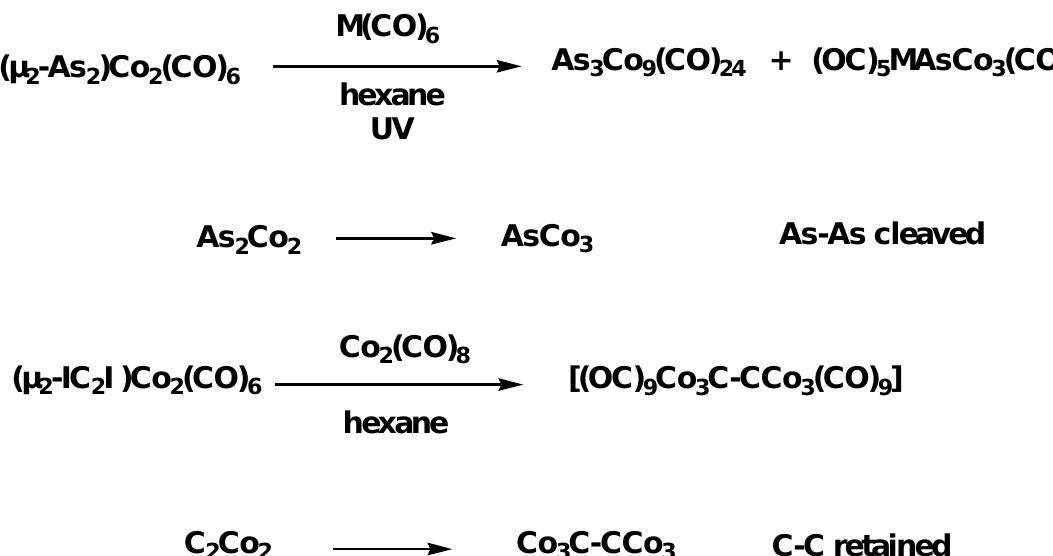
Figure 19. Analogy of heteronuclear cluster transformations with As and C heteroatoms [85,88]. Treatment of the trinuclear complex 10 with P(OPh) 3 yielded in apolar solvent a mixture of its monosubstituted derivative, AsCo 3 (CO) 8 [P(OPh) 3 ] ( 30 ) and that of the dinuclear 6, As 2 Co 2 (CO) 5 [P(OPh) 3 ], indicating an ECo 3 => E 2 Co 2 transformation, that is, the opposite of the former.